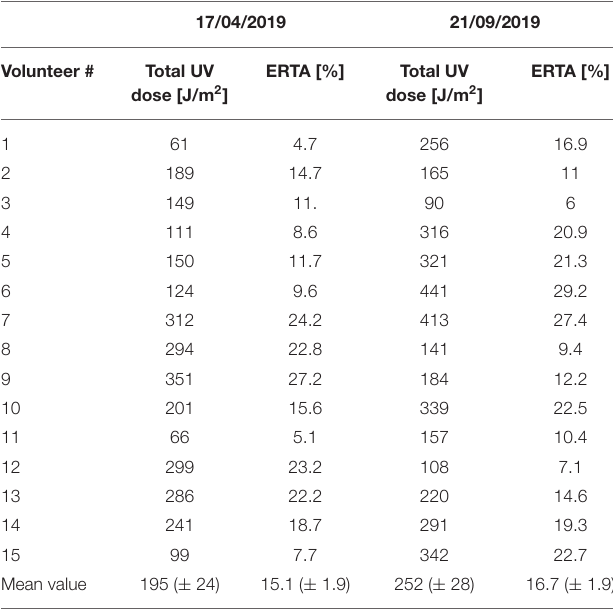
TABLE 2 | Total UV exposure doses for the 15 participants at measurement days in April and